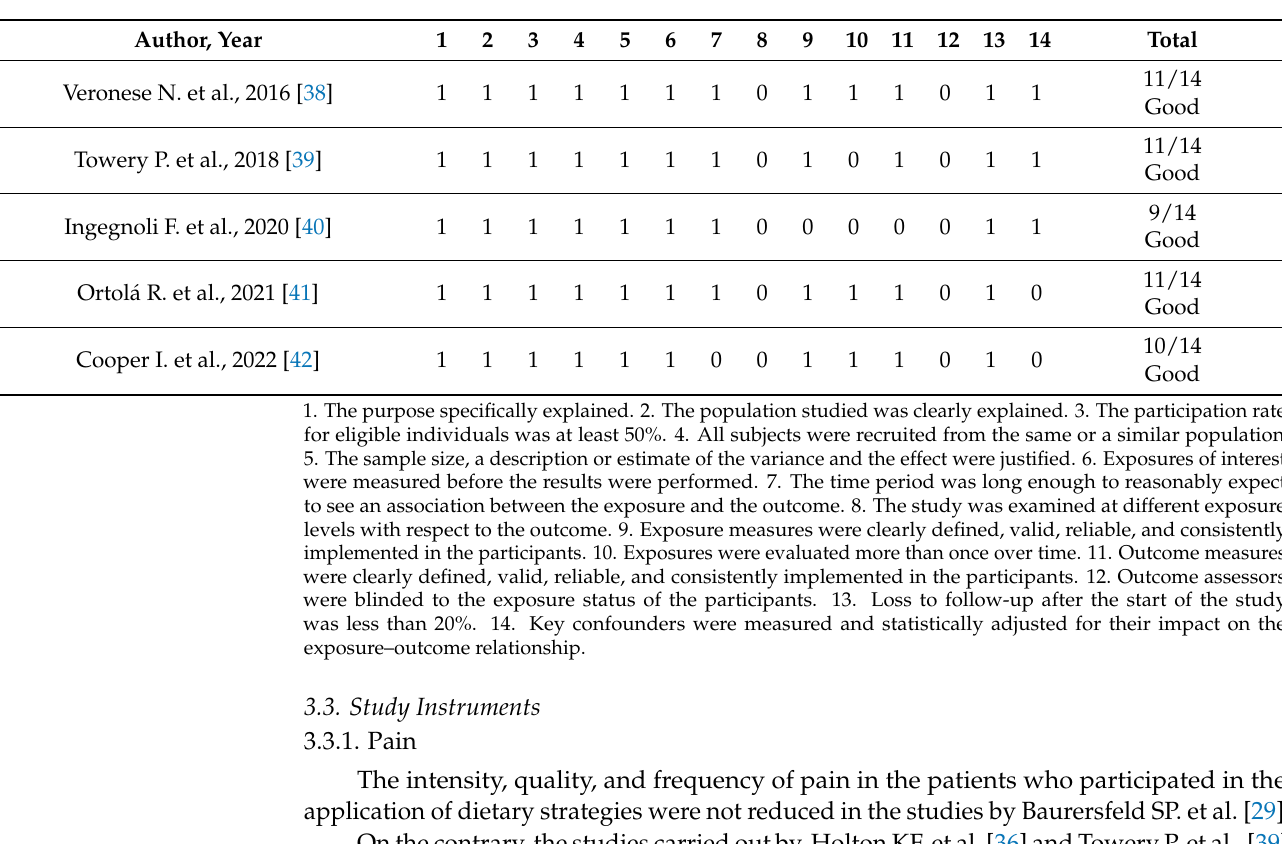
Table 4. Study of the methodological quality of observational studies through the Quality Assessment Tool for Observational Cohort and Cross-Sectional Studies